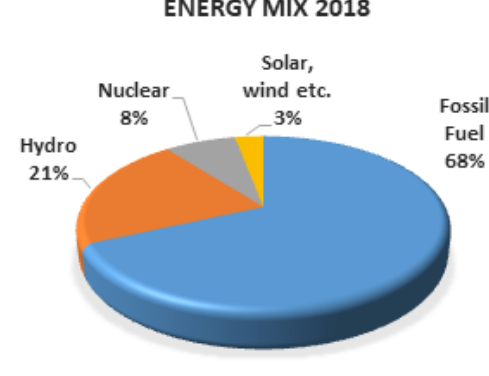
Table 1. Cost of electricity from different types of power plants in Pakistan.